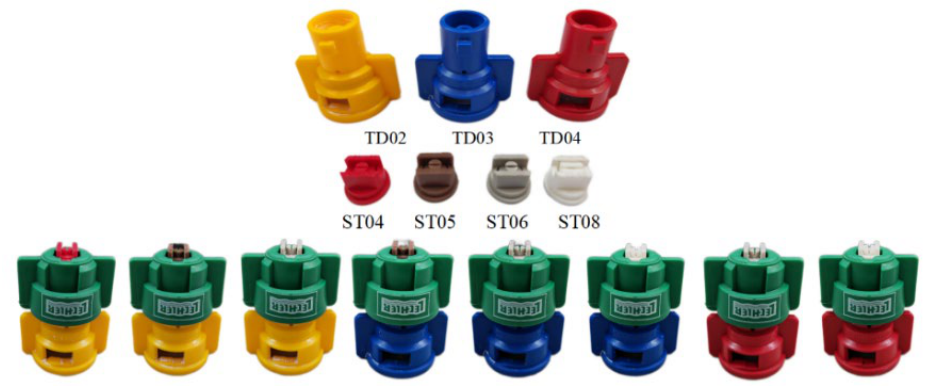
Figure 1. Test combination of TD-ST type AIN.